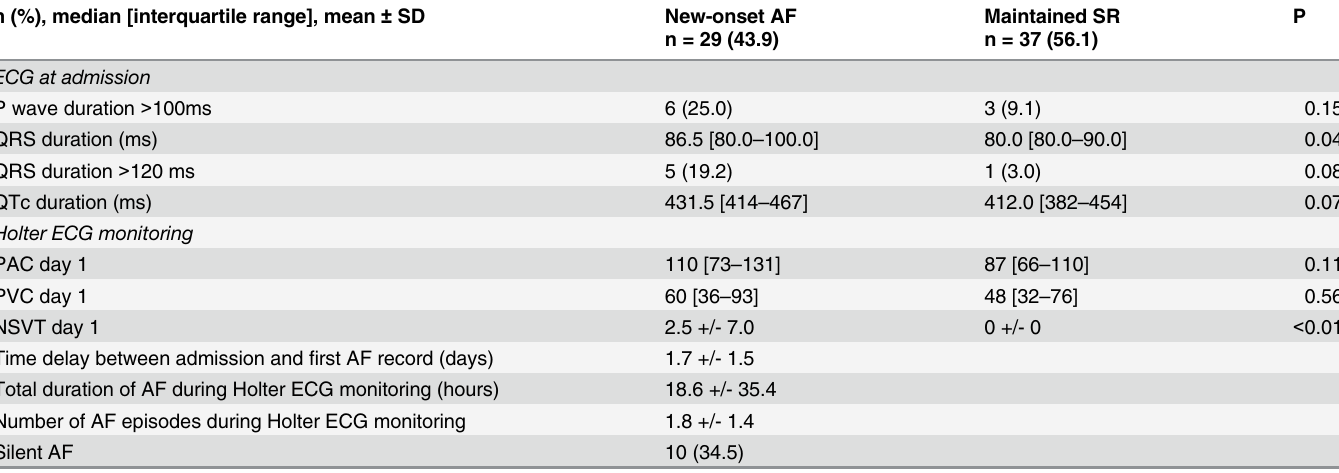
AF indicates atrial fi brillation; ECG: electrocardiogram; QTc: corrected QT; NSVT: Nonsustained Supra ventricular tachycardia; PAC: premature atrial contraction; PVC: premature ventricular contraction.